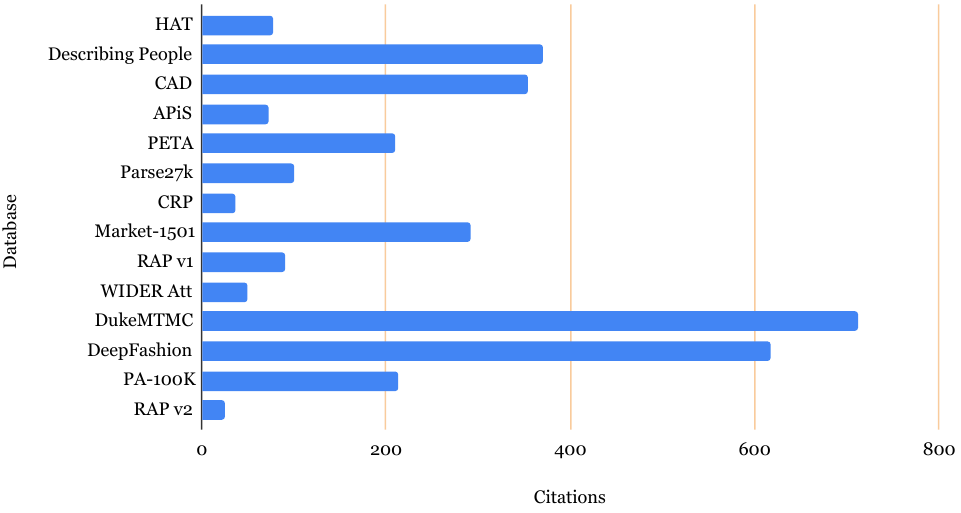
Figure 3. Number of citations to HAR datasets. The datasets are arranged in an increasing order by their publication date. The “oldest” dataset being HAT, published in 2009, while the latest is RAP v2, published in